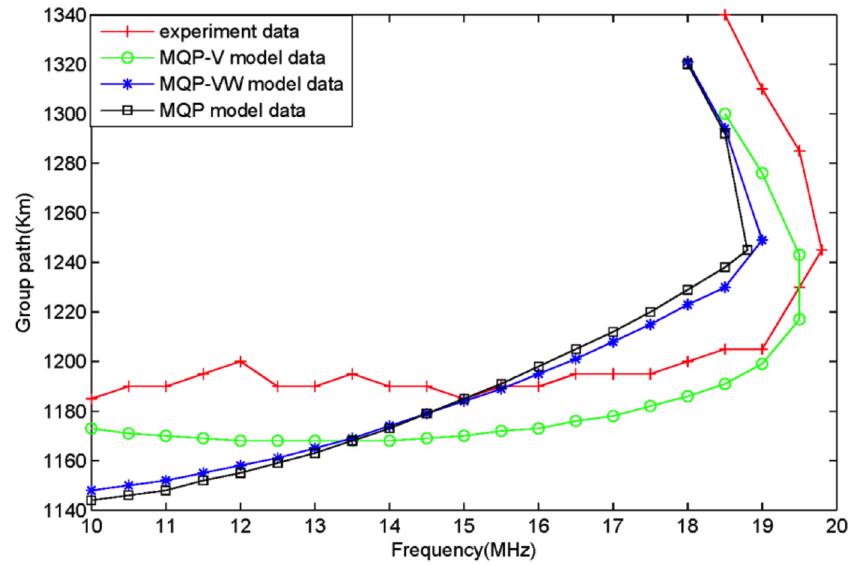
Figure 4. One-hop oblique sounding ionograms generated with the three MQP models and the experimental ionogram. Time: January 4, 2014, at 03:07 (UT).